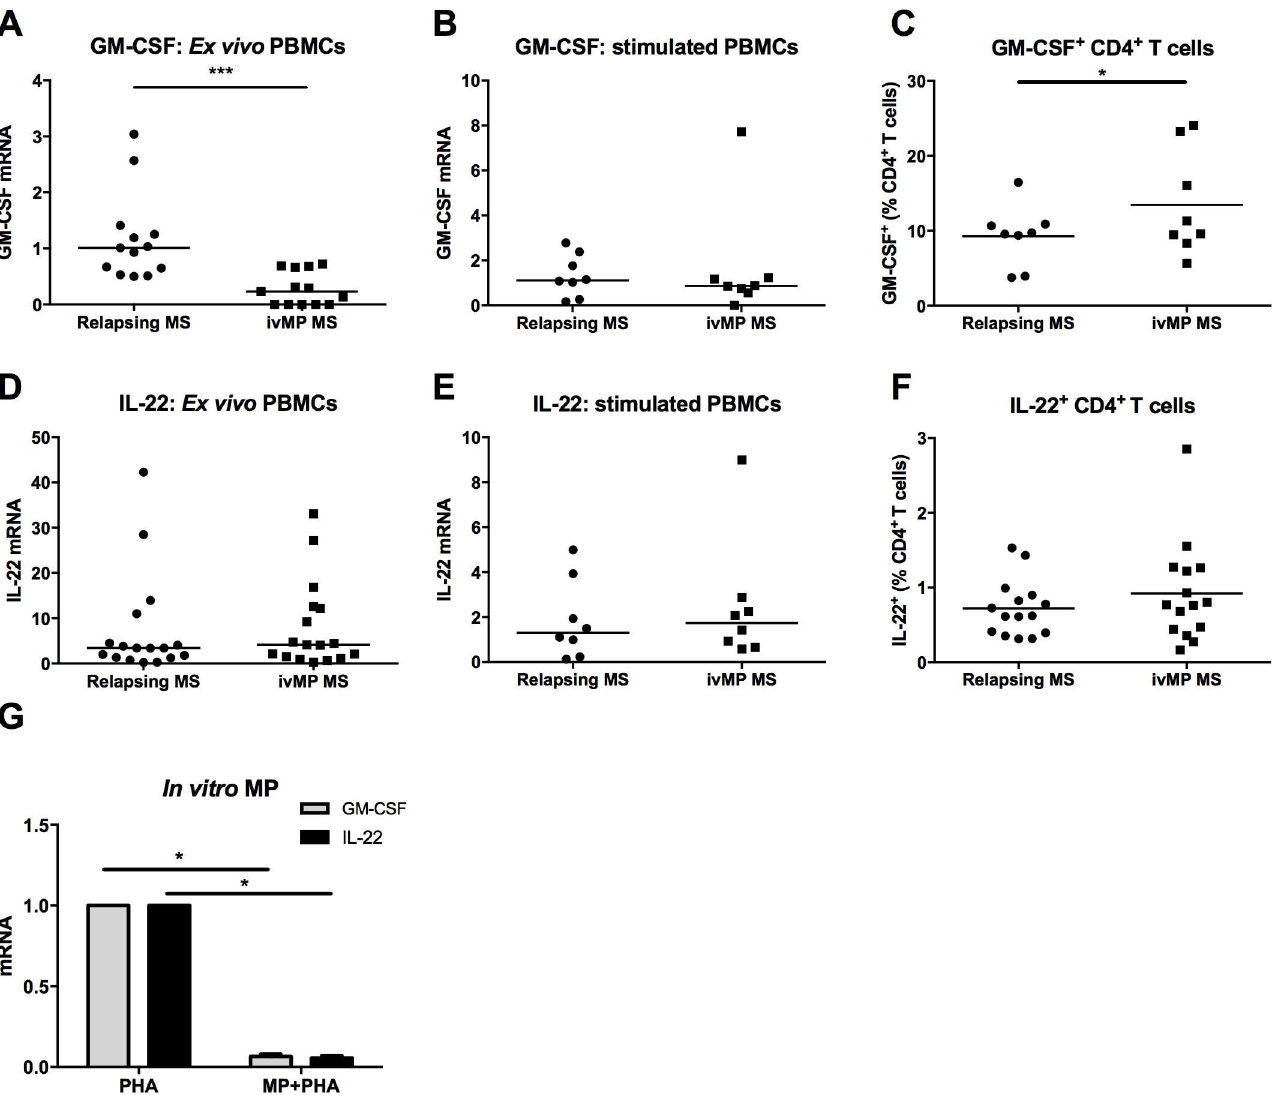
Fig 4. GM-CSF and IL-22 before and after intravenous methylprednisolone (ivMP) treatment in paired samples of relapsing MS patients. Quantitative-PCR to measureGM-CSF and IL-22 mRNA expression ex vivo (A, n = 13 and D, n = 17) and (B, n = 8 and E, n = 8) after 4h stimulation by PMA/ionomycin. Results are expressedrelativeto the mean of the relapsingpatients set at 1. PBMCs were stainedfor GM-CSF (C, n = 8) or IL-22 (F, n = 15), CD3 and CD4 after 4h stimulationby PMA/ionomycin in the presenceof a protein transport inhibitorand analysedby flow cytometry. The horizontallines of scatter plots represent the medianvalue in all subgroups. (G) PBMCs of HC (n = 5) were treated with methylprednisolone(MP) for 24h and stimulated2h with PHA. Error bars represent the standarderror of the mean. * and *** indicate respectivelyp-values (cid:20) 0.05 and (cid:20) 0.001.